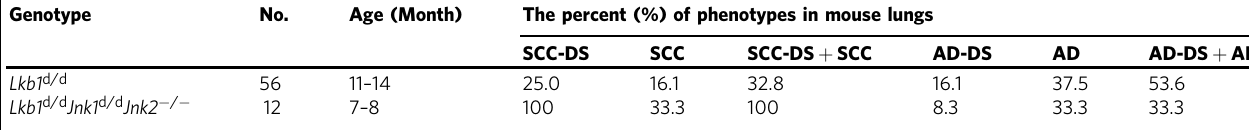
Fig. 7 Working model. Lkb1 loss in airways decreases MKK7 expression levels, reduces JNK1/2 phosphorylation levels and activities, and de- represses oncogenic and squamous linage pathway(s) (e.g. Δ Np63 pathway), which prompts hyperplasia and squamous metaplasia in normal airway cells, breaks the barrier against LSCC formation, and promotes LSCC